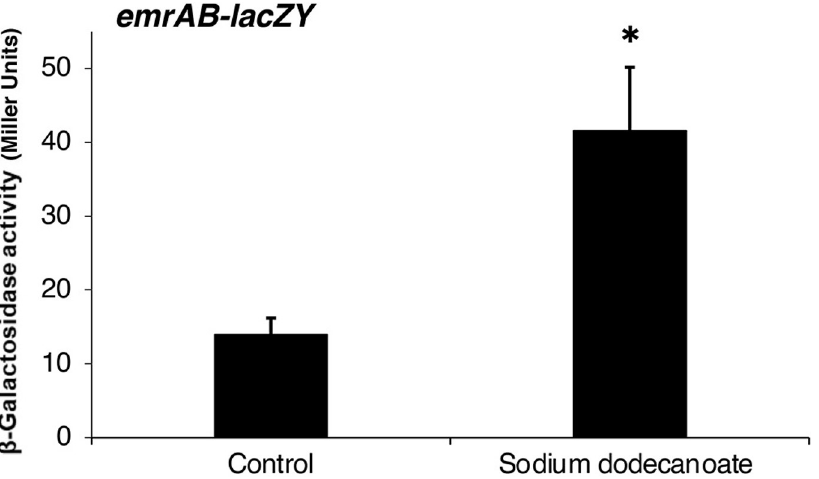
Fig 1. Effect of the fatty acid salt on the promoter activity of emrAB . β -galactosidase activity in S . enterica strain in which lacZY genes replaced the chromosomal copy of emrAB grown with or without sodium dodecanoate (C12). Activities of EG15129 were determined as described in Materials and Methods. The value displayed correspond to mean values of five independent experiments. Error bars correspond to the standard deviation. Student’s t -test; � , P < 0.01 versus